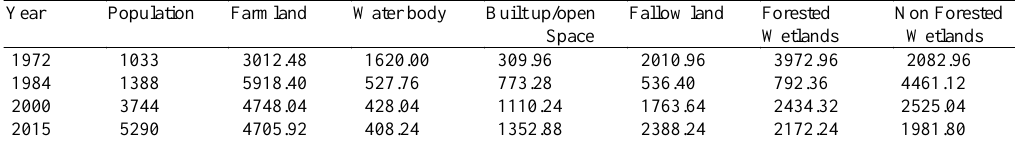
Table 6: Population and land use patterns of the study area in 1972, 1984, 2005 and 2015 (Adeleke,